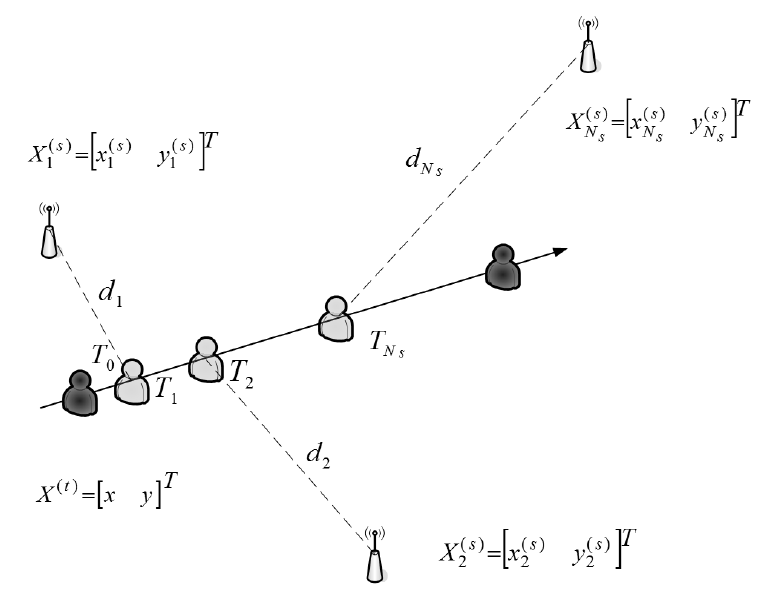
Figure 2. Differences between signal arrival time stamps.